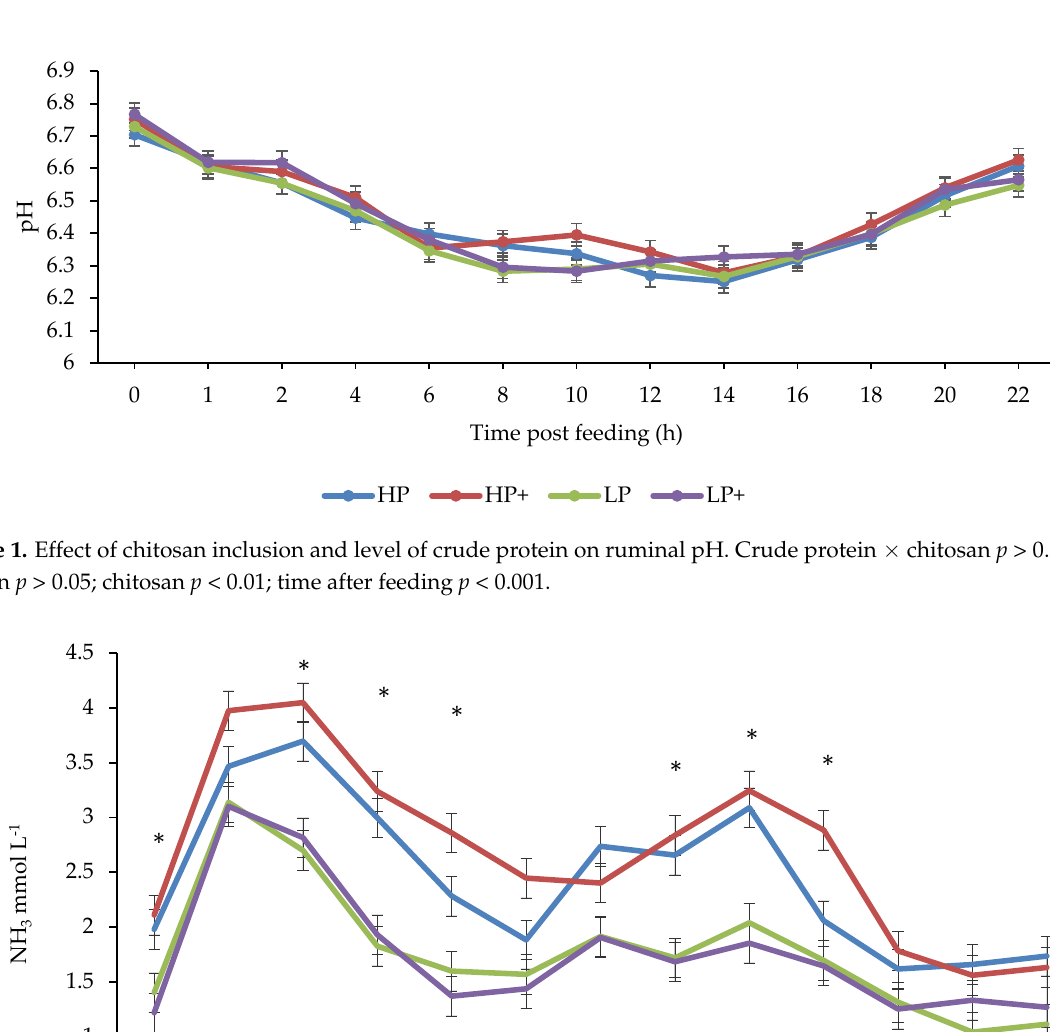
protein level and chitosan inclusion had no effect on ruminal valeric acid, iso-valeric acid, and iso-butyric acid concentrations ( p >